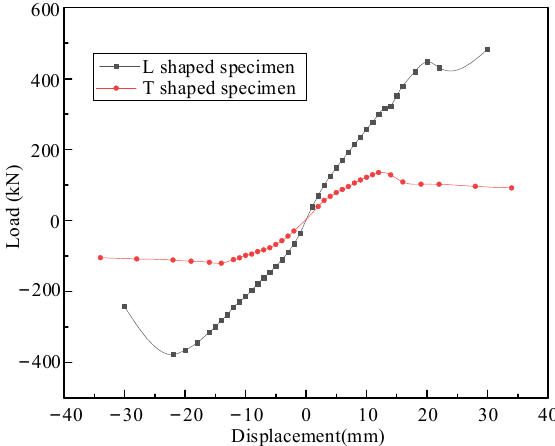
Figure 12. Specimen skeleton curve.